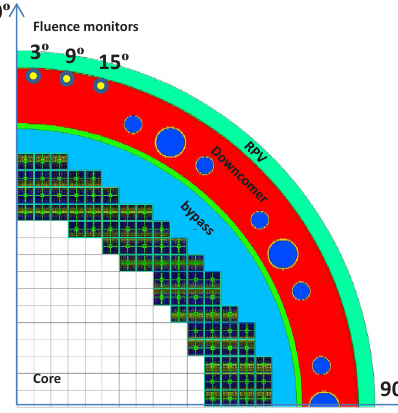
Figure 2. Simplified illustration on the Swiss BWR validation case.